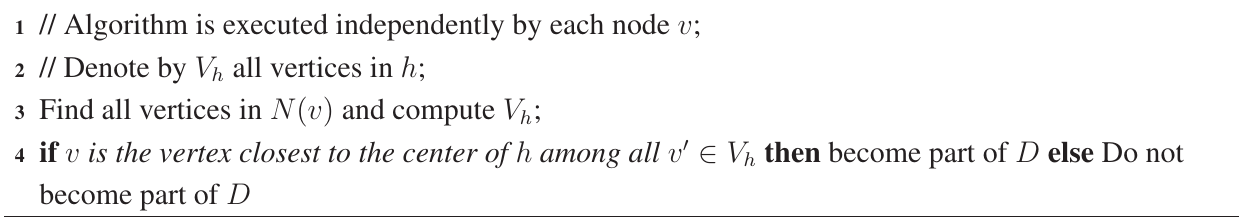
Algorithm 1 : Local algorithm for finding a dominating set in a unit disk graph // Algorithm is executed independently by each node v ;